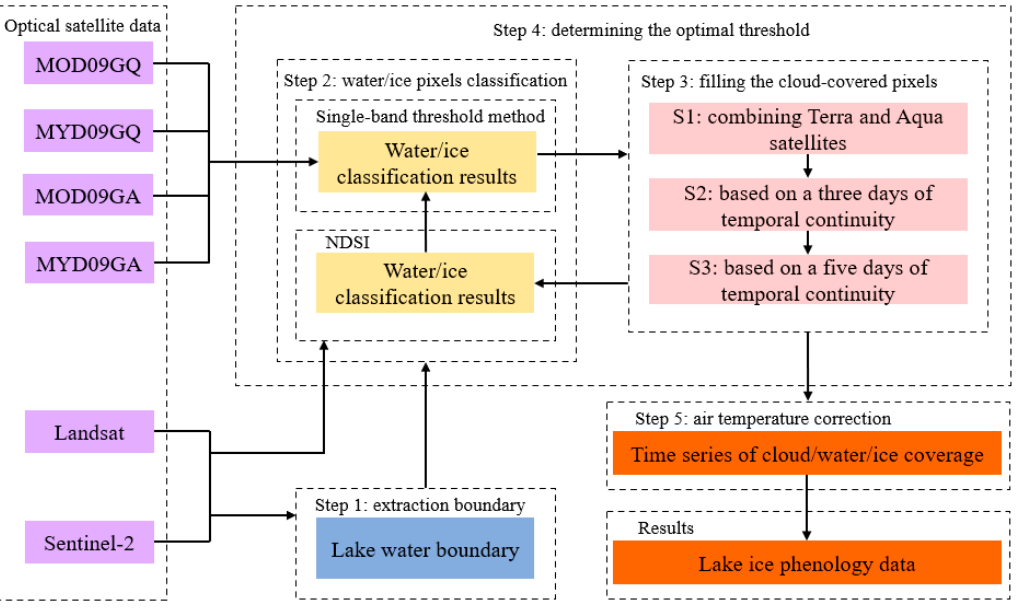
Figure 3. Algorithm flow chart.